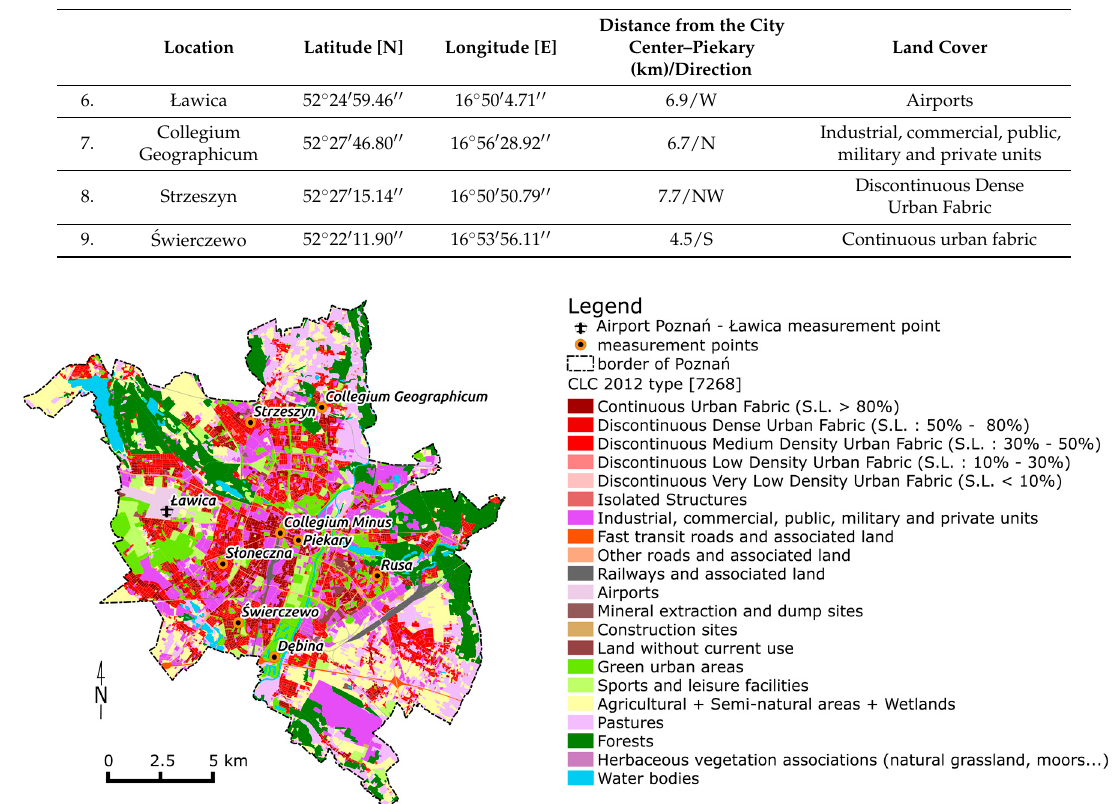
Figure 1. Location of measuring points against the type of land use (Urban Atlas 2012).